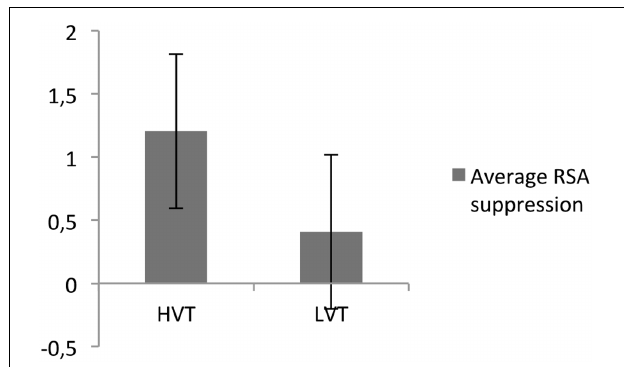
FIGURE 2 | Respiratory sinus arrhythmia suppression for participants with high (HVT) and low (LVT) RSA baselines.